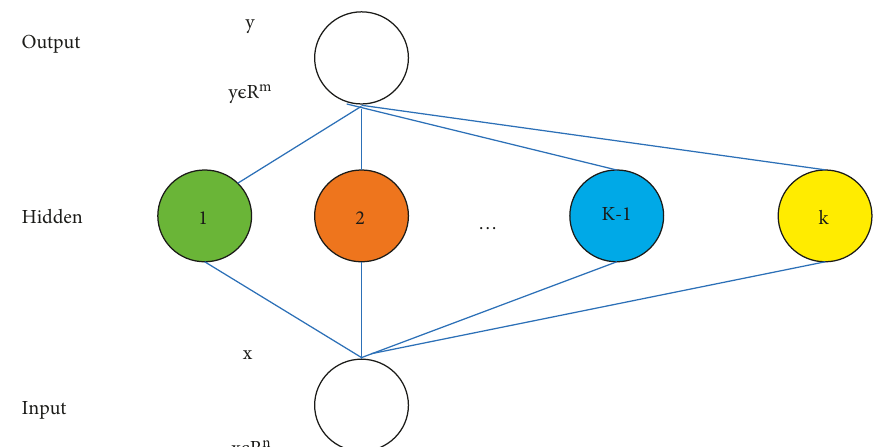
Figure 2: Network framework of TSVD-SCN.